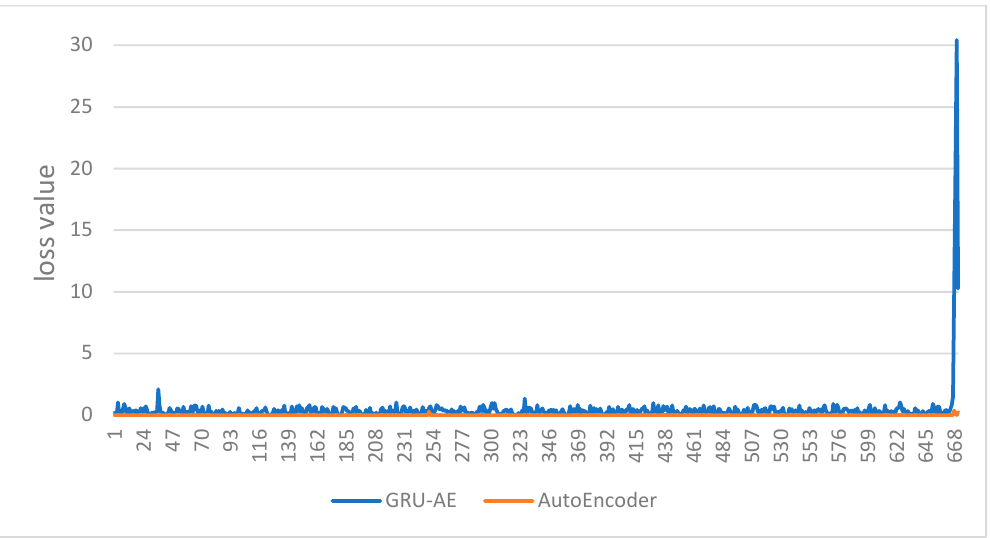
Figure 15. Comparison of input and output of GRU-AE model in test set 2.